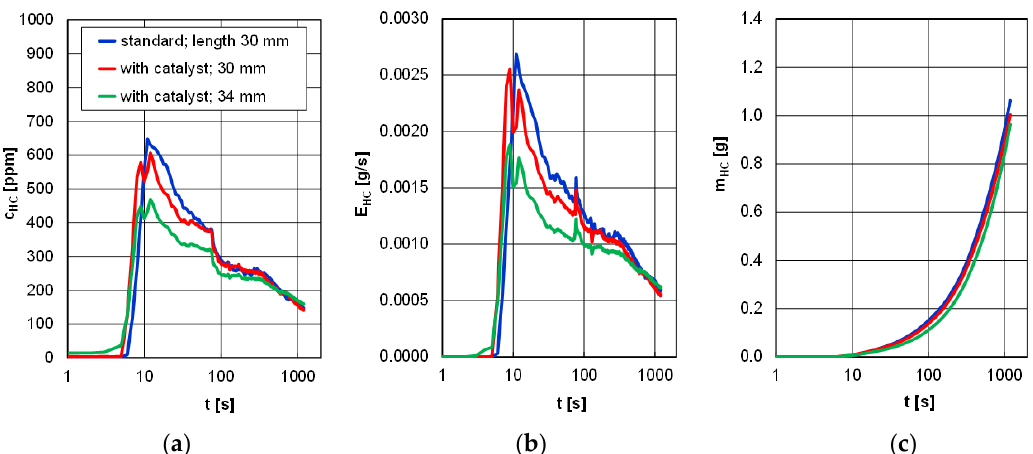
Figure 9. Concentration ( a ), emission rate ( b ), and emission of hydrocarbons ( c ) during the tests of a diesel engine depending on the type of glow plugs and the length of the catalyst-covered ones.